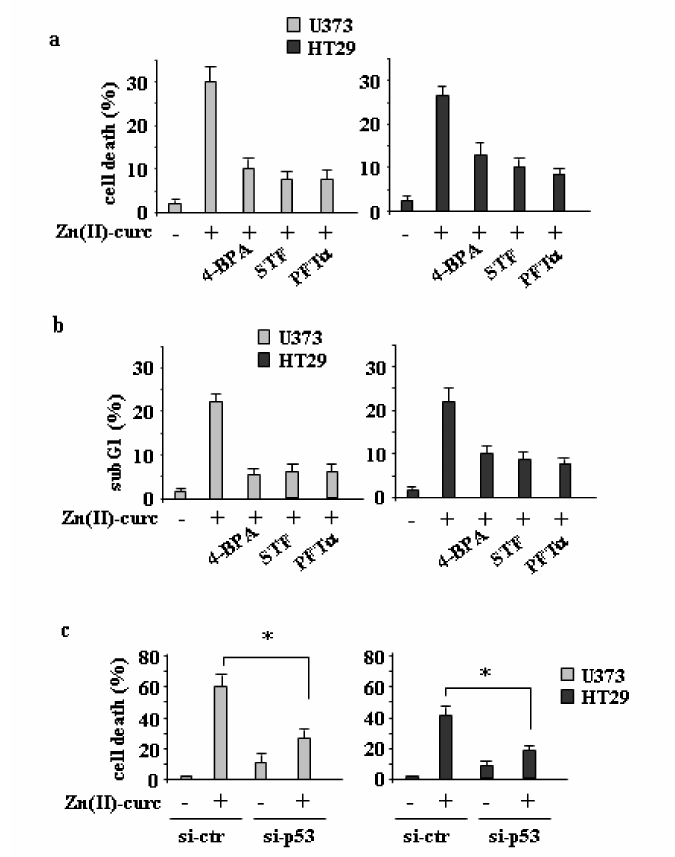
Figure 5. ER stress or IRE1 α inhibition impair Zn (II)-curc-induced cell death. ( a ) Cell viability was measured by trypan blue exclusion assay in U373 and HT29 cells untreated or treated with Zn (II)-curc (100 µ g / mL) for 24 h, with or without the inhibitor of XBP1 cleavage STF (60 µ M), p53 inhibitor PTF- α (30 µ M), or 1 h pre-treatment with 4-BPA (2.5 mM), and expressed as percentage ± SD of three independent experiments. * p ≤ 0.05 (combination treatments vs. Zn(II)-curc). ( b ) Cytofluorimetric analysis of the SubG1 peak evaluated by Propidium Iodide (PI) staining of U373 and HT29 cells untreated or treated as in ( a ) for 24 h. Percentage of apoptotic cells is shown ± SD of two independent experiments. ( c ) U373 and HT29 cells were transfected with control pSuper (si-ctr) and pSuper-p53 (si-p53) vectors for p53 knockdown and 36 h after transfection, cells were treated with Zn(II)-curc (100 µ g / mL) for 24 h. Cell viability was measured by a trypan blue exclusion assay and expressed as percentage ± SD of three independent experiments. * p ≤